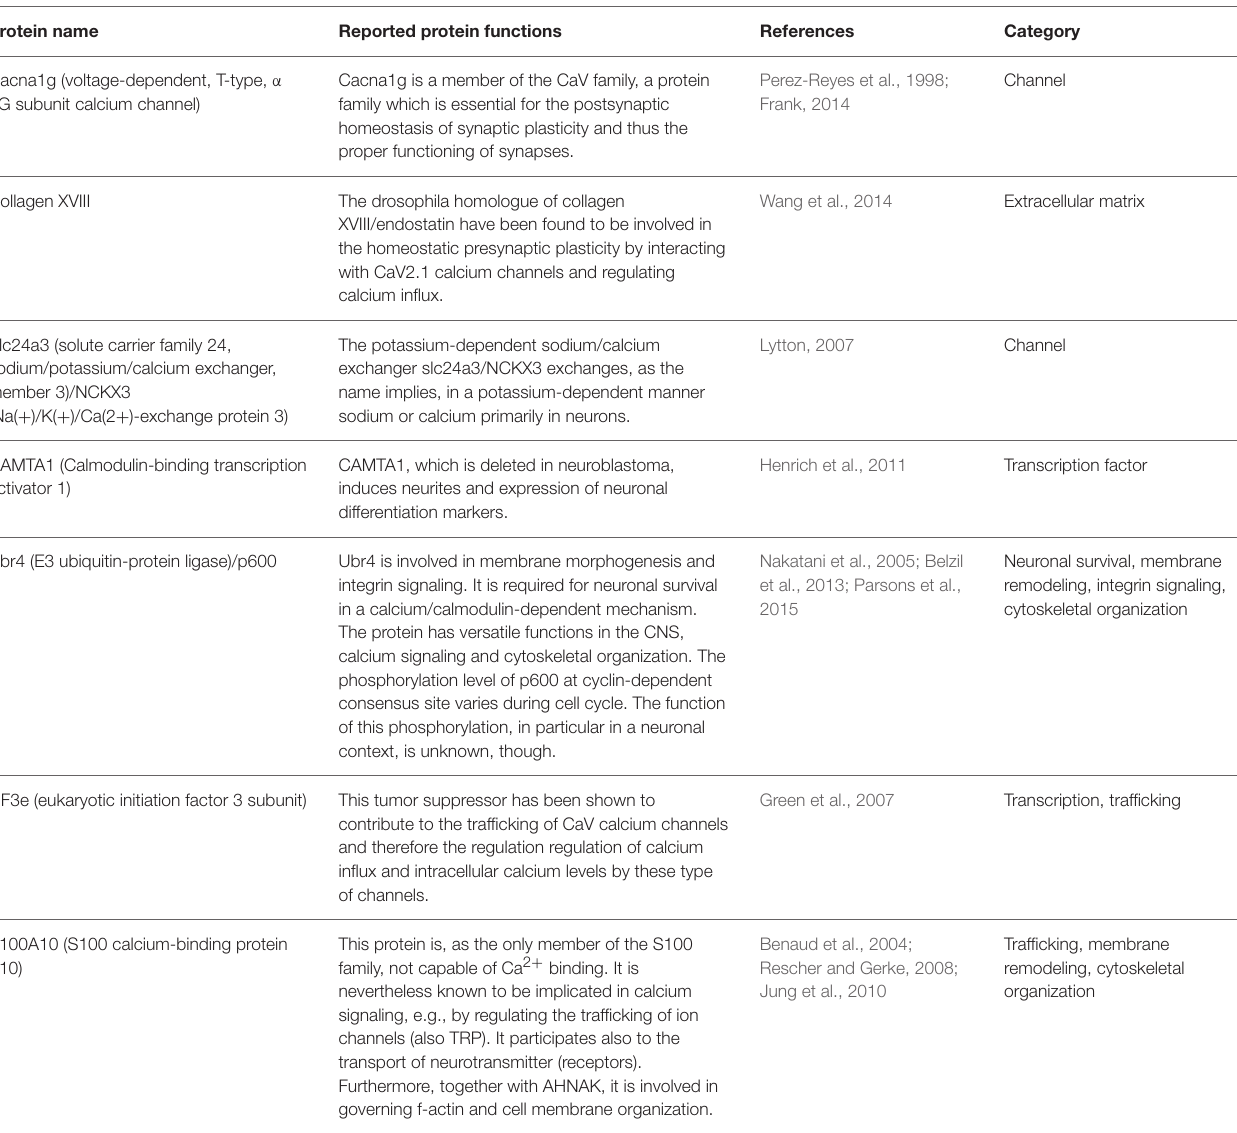
TABLE 9 | Comparison among all conditions with focus on proteins involved in calcium signaling and homeostasis. Associated